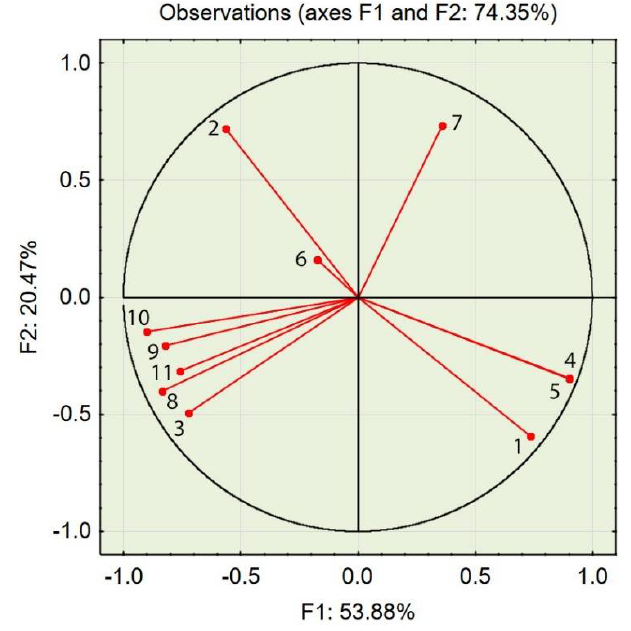
Figure 5. PCA projection of variables set in a 2D factor loading space (for the variable designa- tions, see Table 5). see Table